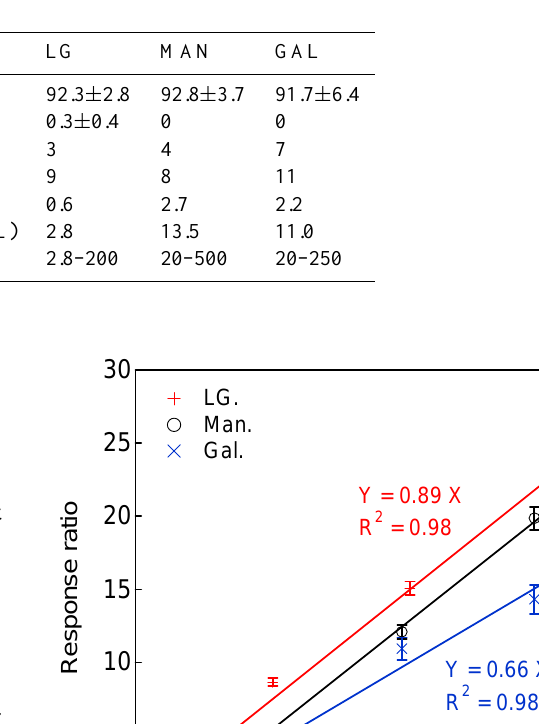
Table 1. Summary of the validation parameters for the TE-GC-GC-MS method. Shown are the mean and standard deviation for n =5.